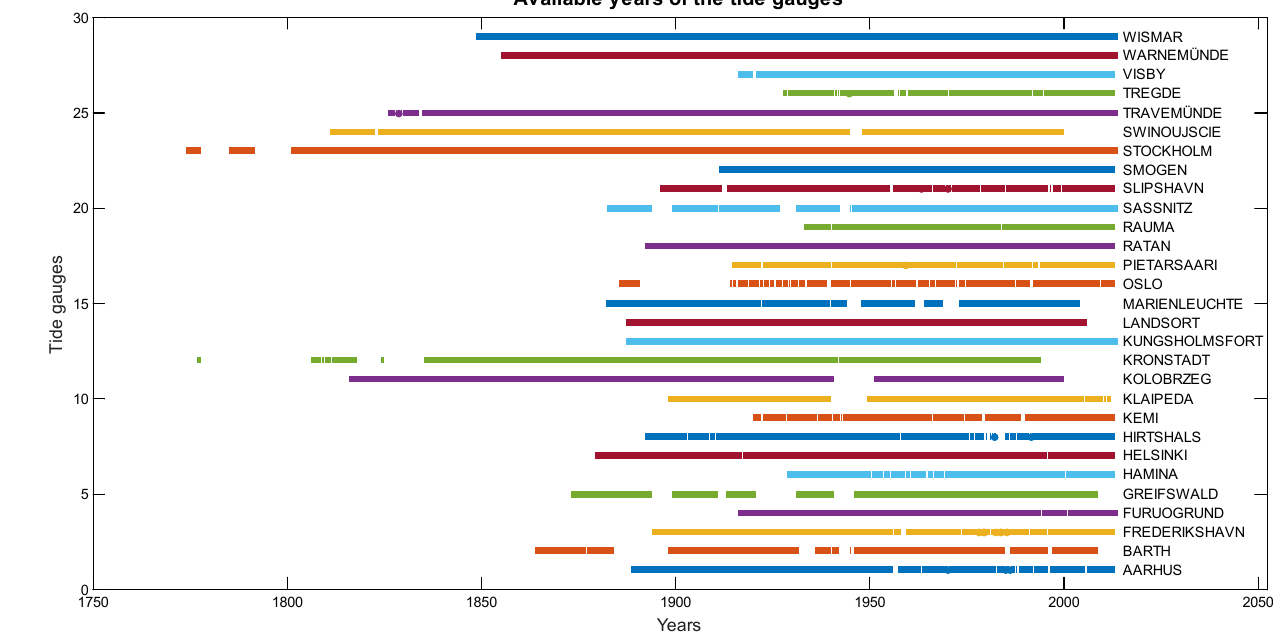
Figure 2. Time coverage of the tide gauge observations (monthly means). Numbers on the y axis refer to the station number defined in Fig. 1. Time series are coloured for better